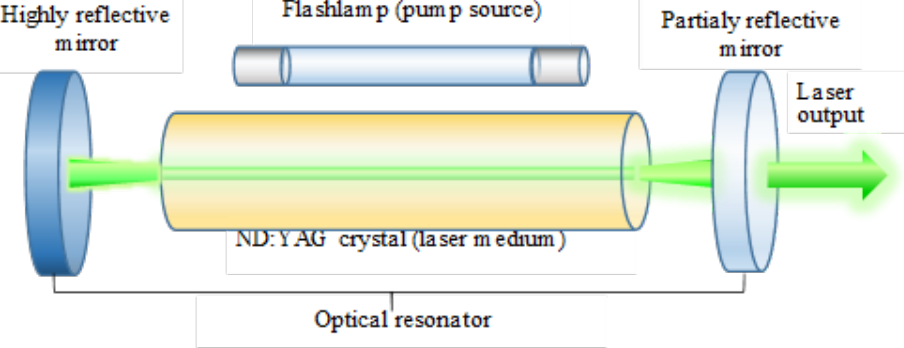
Figure 2. Schematic diagram of a solid-state Nd: YAG laser (green laser). Light particles (photons) excited by electricity emit energy in the form of light.